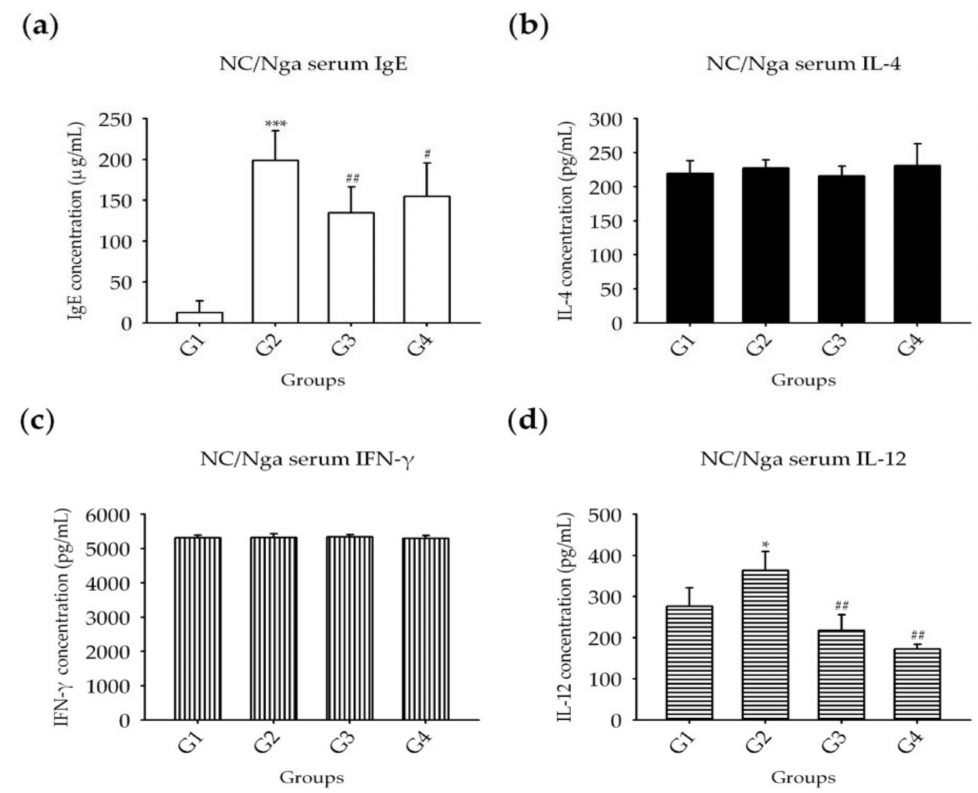
Figure 9. Serum IgE and cytokine levels after ASex treatment in NC / Nga mice. ( a ) Level of serum IgE; ( b ) level of IL-4; ( c ) level of IFN- γ ; ( d ) level of IL-12. G1: negative control group; G2: positive control group (HDM only); G3: drug control (0.1% Hc); G4: 1% ASex. All groups were induced with HDM except for G1. The results are expressed as the mean ± SD of triplicate experiments ( n = 3). Statistical significance was assessed by ANOVA: * p < 0.05, *** p < 0.001 compared with G1. # p < 0.05, ## p < 0.01 compared with